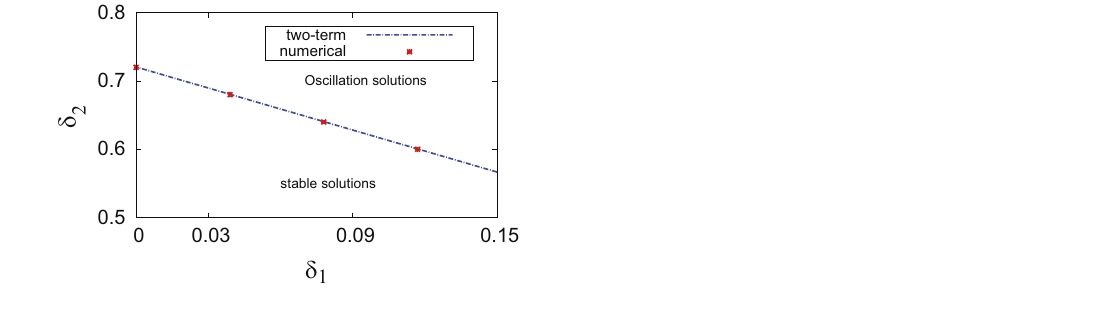
Figure 7: The δ δ − 1 2 parameter plane representing the locus of the degenerate Hopf curve at